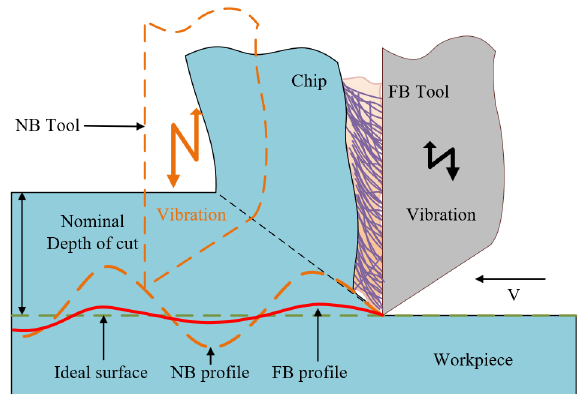
Figure 17. Vibration waveform of broaches with different surfaces.